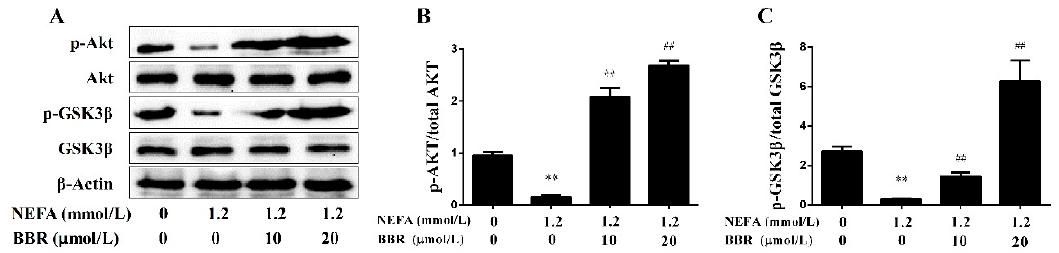
Figure 6. BBR improved the NEFA-induced insulin signaling damage in bovine hepatocytes. Hepatocyte treatment is described as in Figure 5. ( A – C ) Western blot analysis and quantification of key molecules of the insulin signaling pathway, β -Actin served as an internal control. Quantified data are mean ± SD; ** p < 0.01 versus control group; ## p < 0.01 versus NEFA group.